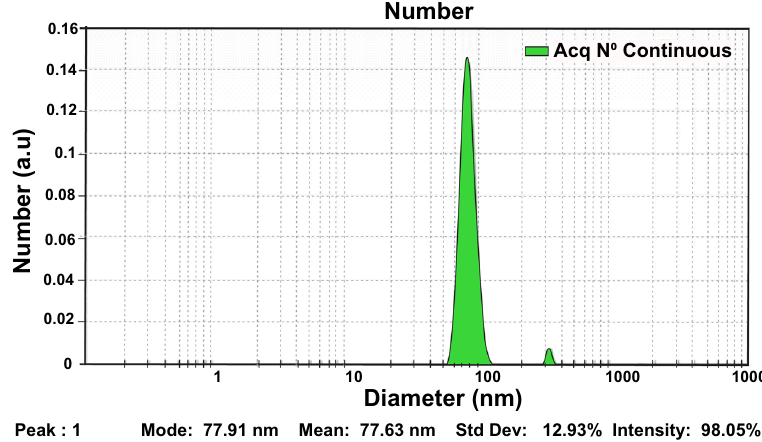
Fig. 1 The hydrodynamic size distribution of TiO 2 (Anatase) NPs at pH 7.4 and temperature 25 °C using the DLS